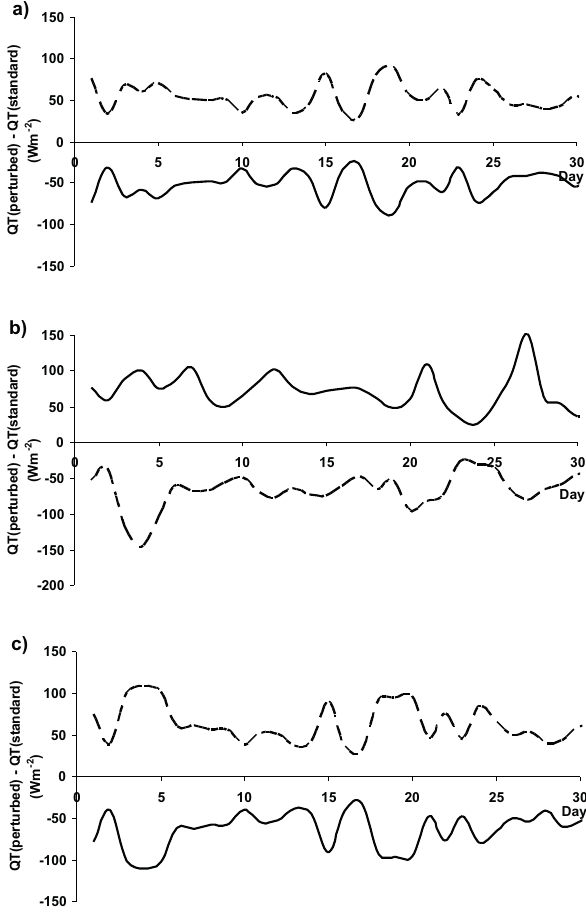
Fig. 11. The change in QT (net heat flux from the ocean to the atmo- sphere) in Wm − 2 for (a) an increase of 20% (solid line) and a de- crease of 20% (dashed line) of humidity, (b) an increase of 2ms − 1 (solid line) and a decrease of 2ms − 1 (dashed line) of wind speed and (c) an increase of 2 ◦ C (solid line) and a decrease of 2 ◦ C (dashed line) of air